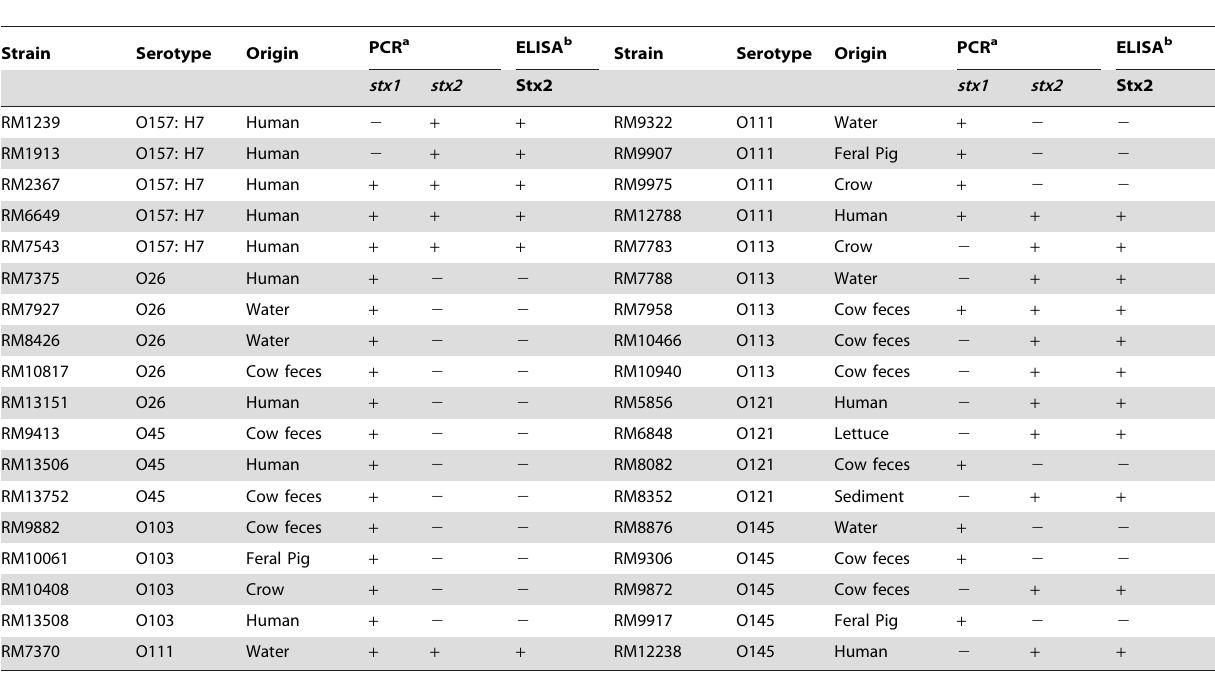
Table 2. Results of PCR and ELISA for detection of Stx2 in E. coli strains isolated from human and environmental samples.